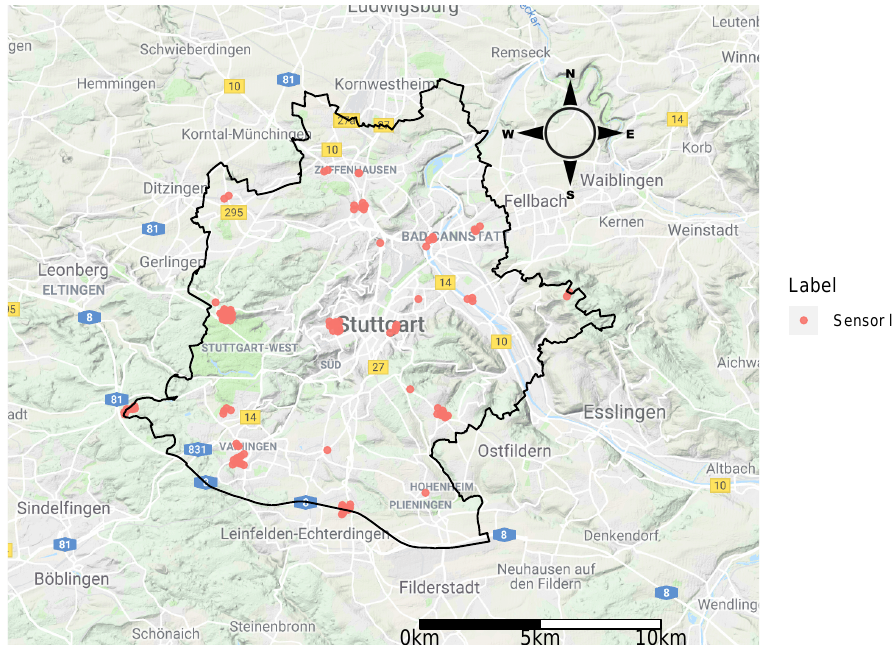
Figure A2. Optimal locations considering prediction error constraint for Stuttgart LUR model developed using low-cost sensor network